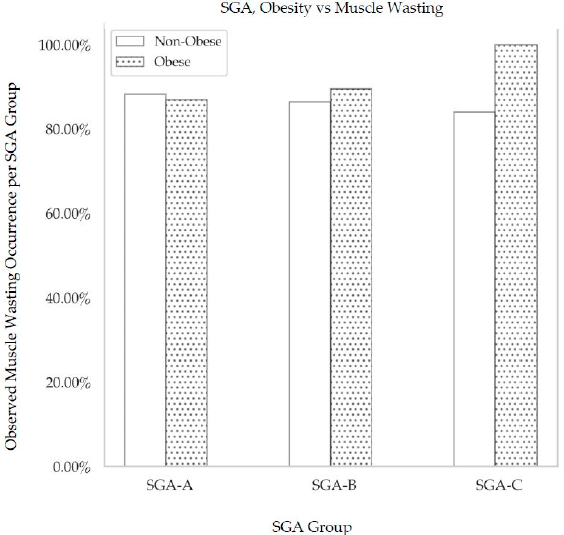
Figure 3. The distribution of sarcopenia across SGA categories. SGA, subjective assessment of nutritional status: SGA A, well nourished; SGA B, moderately malnourished; SGA C, severely malnourished. The observed percentage of muscle wasting occurrence per SGA group did not vary significantly across SGA groups based on either obesity or nutritional status.